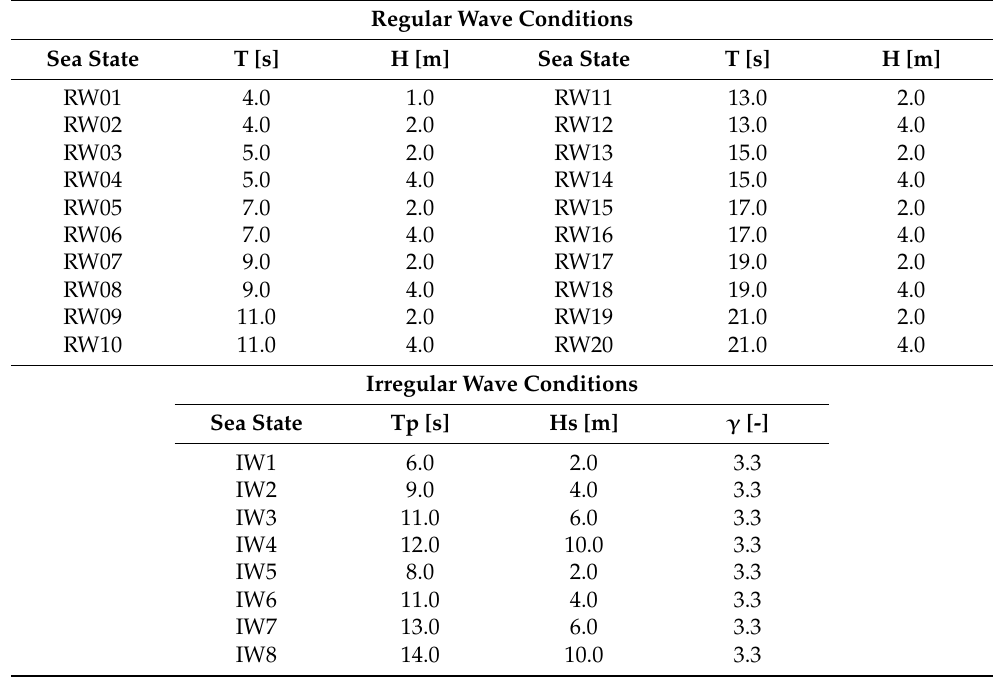
Table 1. Wave conditions (real